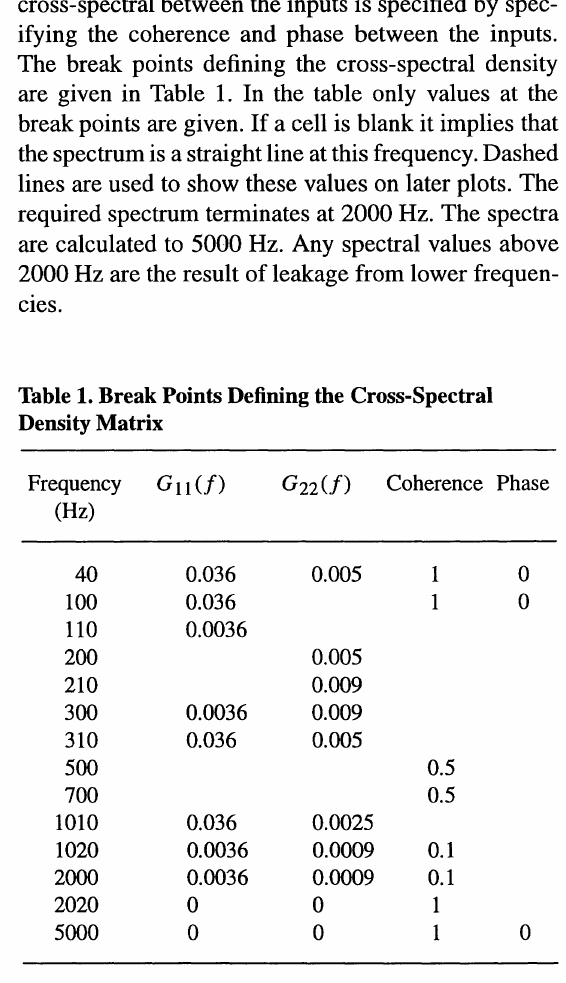
Table 1. Break Points Defining the